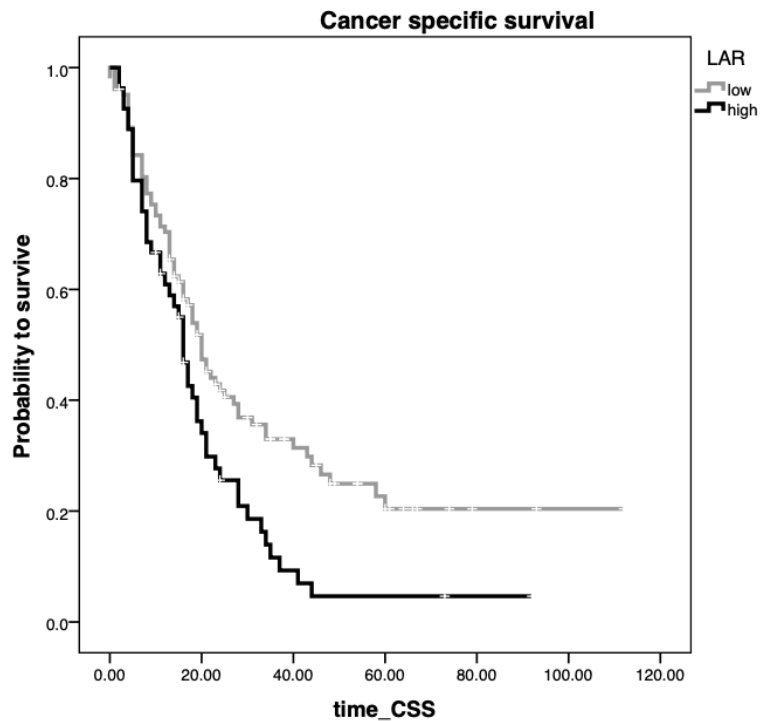
Figure 1. Kaplan–Meier curves predicting cancer-specific survival (CSS) regarding a preoperative LAR < 2.74 vs. LAR ≥ 2.74 in the study cohort comprising 157 patients undergoing surgical resection ( p = 0.008).